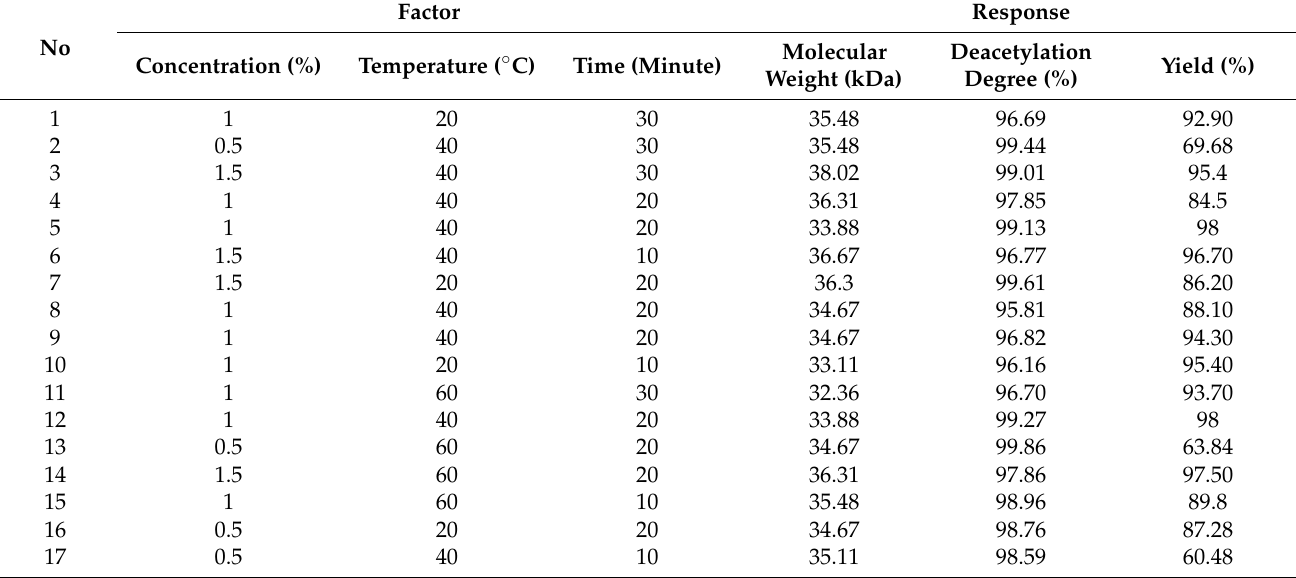
Table 6. Box Bhenken Design and